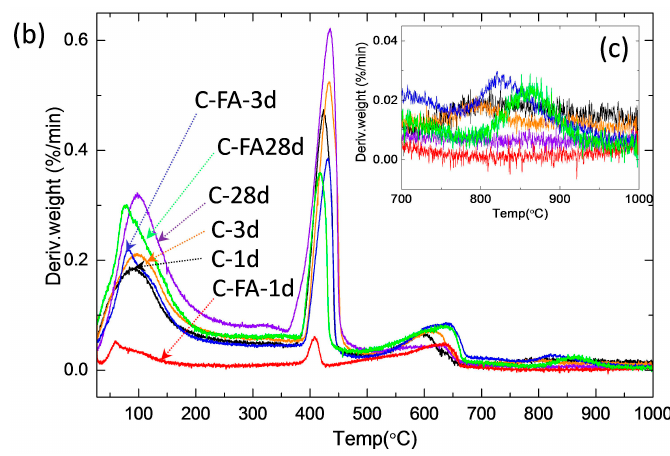
Figure 2. Results of thermal analysis. ( a ) TG and ( b ) DTG results of the C and C-FA.